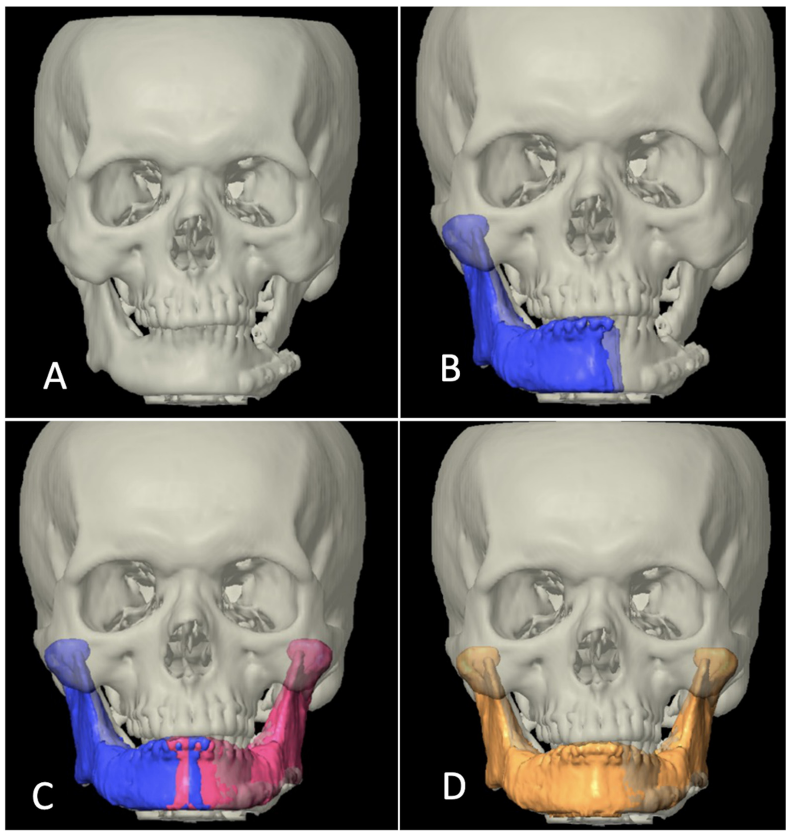
Figure 2. Designing template in category I. ( A ) 3-dimensional view of defect. ( B ) Segmentation of right hemimandible (blue color). ( C ) Mirroring to the left side (pink color). ( D ) Merging both sides to form simulated whole mandible for printing (yellow color).